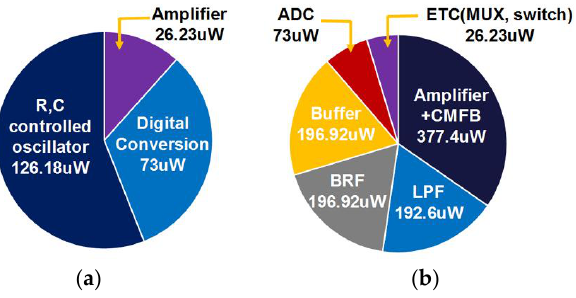
Figure 13. Power breakdown of the sub-blocks: ( a ) oscillator-based circuits and ( b ) amplifier-based circuits.